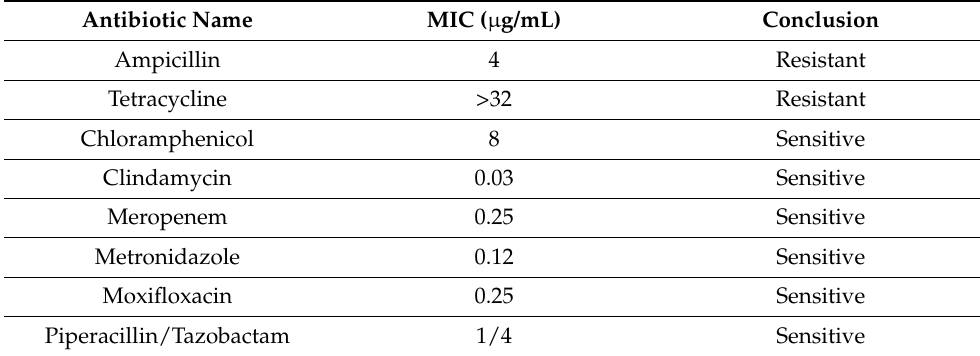
Table 2. Antibiotic resistance profile of C. minuta DSM 33407. MIC : Minimum Inhibitory